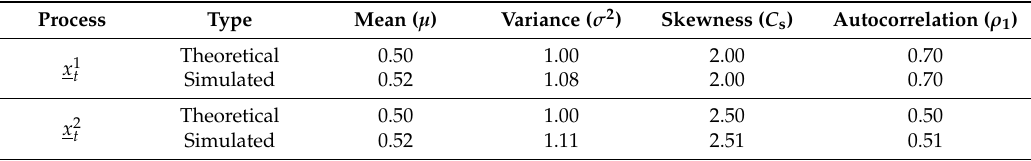
Table A3. Summary of theoretical and simulated statistics for the second, autocorrelated, bivariate AR(1) process with P III white noise, employed in Section 2.3—“From the univariate to the multivariate AR(1) model” of the main manuscript.